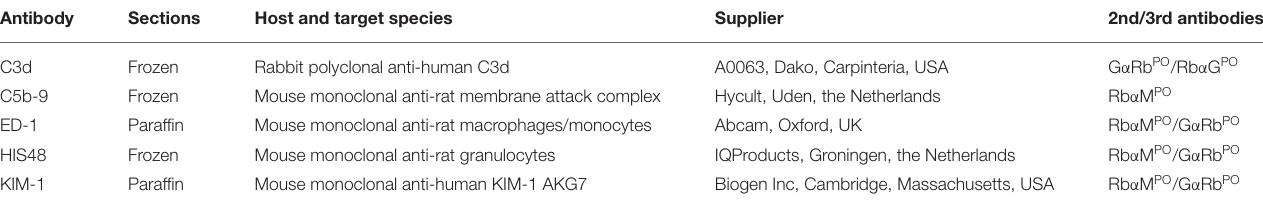
TABLE 2 | Primary antibodies used for immunohistochemistry. Antibody